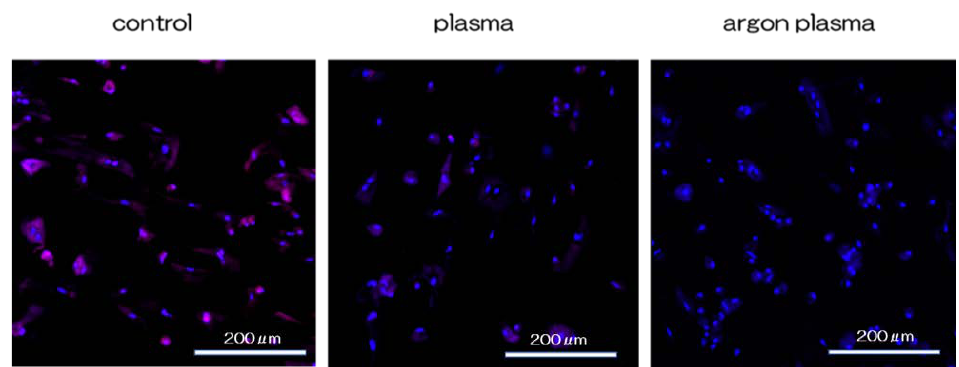
Figure 8. RBMCs on the titanium surface showed significantly higher levels of intra cellular ROS, than the RBMCs on the plasma-treated titanium surface, and the lowest ROS levels in the argon plasma-treated group. These results indicate that argon plasma treatment may enhance the antioxidant properties of titanium surfaces.